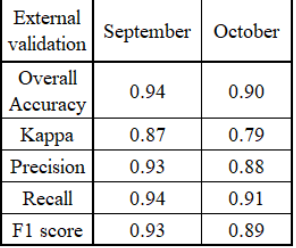
Table 3 . Results from external validation for the months of